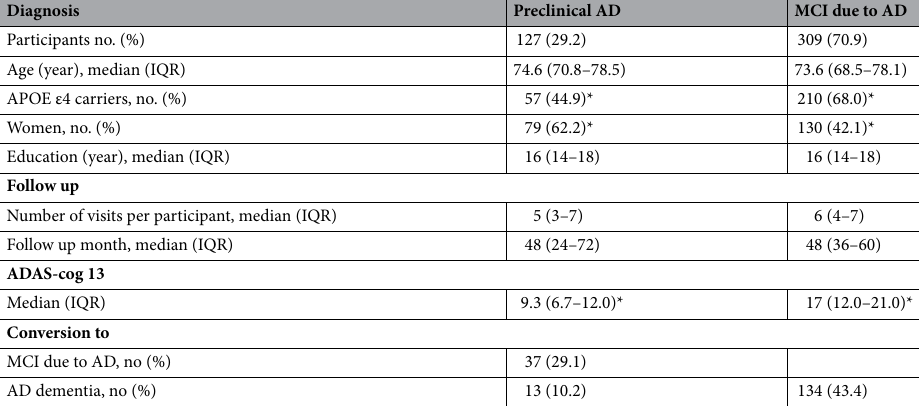
Table 1. Demographics and clinical features of participants with AD. Age, education, ADAS-cog 13 and month of follow-up are expressed as median (IQR). Categorical variables are expressed as no (%). Statistical analyses are performed with Chi-squared tests for APOEε4 carriers and sex. Mann Whitney test for age, education and ADAS-cog 13. AD: Alzheimer’s disease; ADAS-cog: Alzheimer’s disease assessment scale- cognitive subscale; APOE: apolipoprotein E; IQR: interquartile range; MCI: mild cognitive impairment. * p < 0.05 between preclinical AD vs. MCI due to AD.